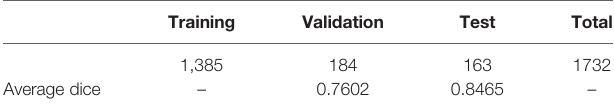
TABLE 4 | Performance of patch-level